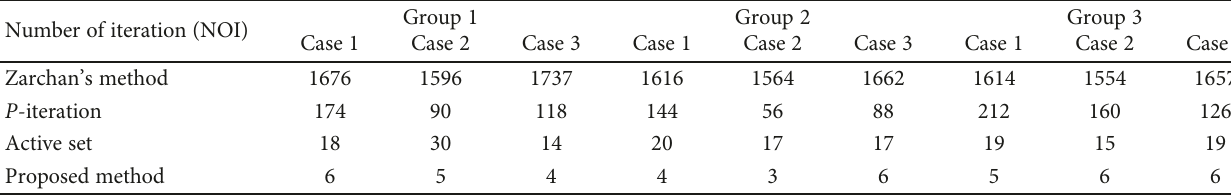
Table 3: Comparisons of the number of iteration.